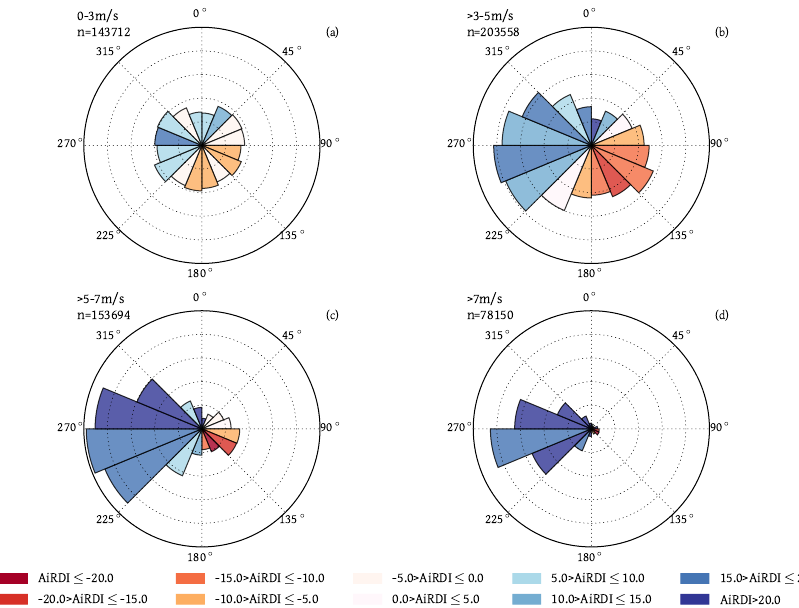
Figure 6. Relationship between the AiRDI (AOD rank − PM10 rank ), wind direction and wind speed for the study area. Figures ( a – d ) represent a wind speed class as shown on the upper left of each panel. Polar bars enclose a wind direction class, each 22.5 ◦ in range. Colors indicate the mean AiRDI for each polar bar, the radius of each bar indicates the frequency of